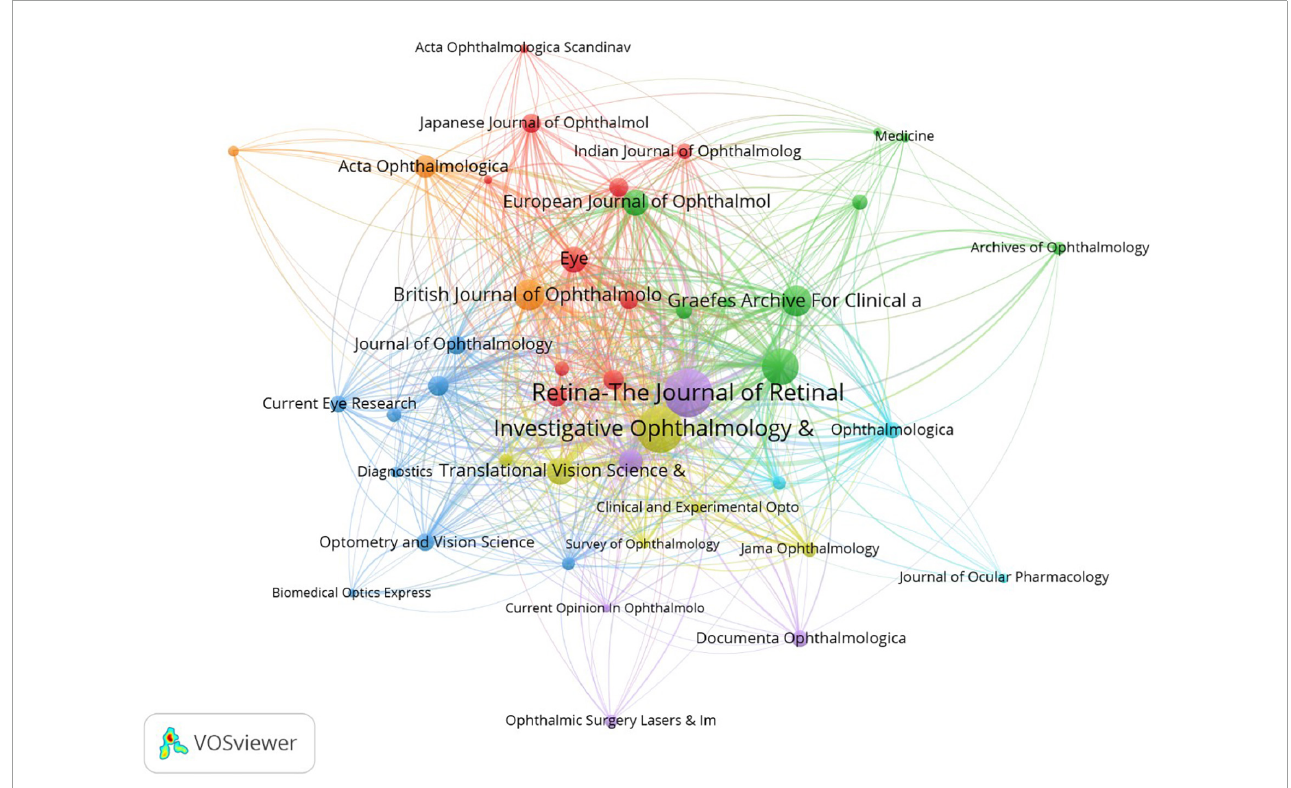
FIGURE8 Journal analysis. The size of nodes demonstrated the number of publications by journals. The curves between the nodes illustrated the citation relationship. The color showed the clustering of journals.